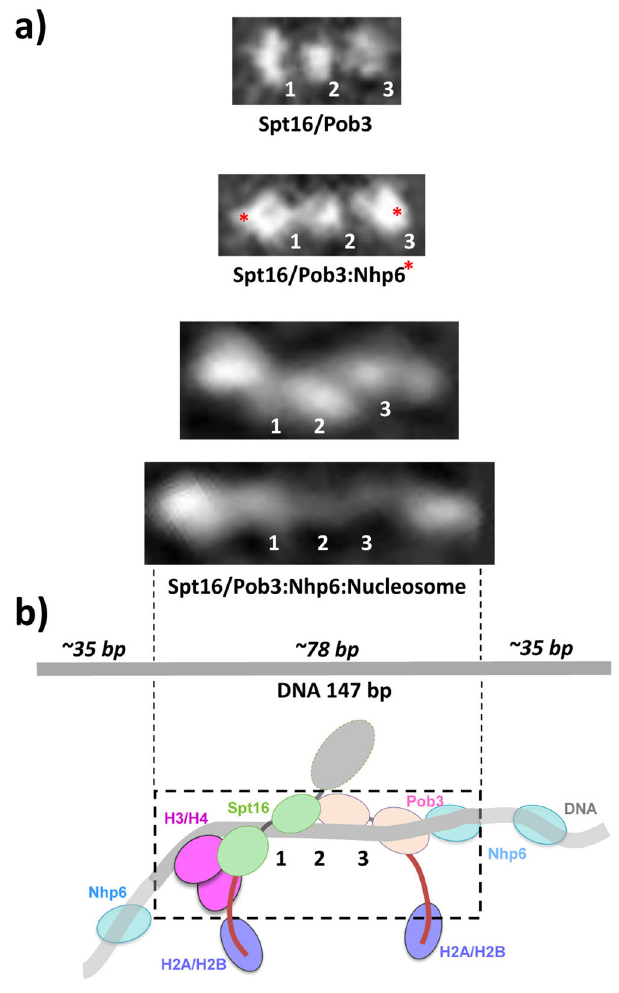
Fig. 4 Comparison of the structures of different FACT-containing complexes. a The most extended class averages for FACT, FACT:Nhp6, and FACT:Nhp6:nucleosome complexes are shown, with the densities for Nhp6 assigned from difference maps for FACT vs FACT:Nhp6 or proposed for nucleosomal complexes (red asterisks). Numbers indicate the same proposed domain assignments in each set, as in Fig. 2b. Scale bar: 10 nm. b A schematic representation of the proposed domain assignments with a 147 bp DNA molecule shown to scale. The region represented in the most extended class average image is indicated by a dashed